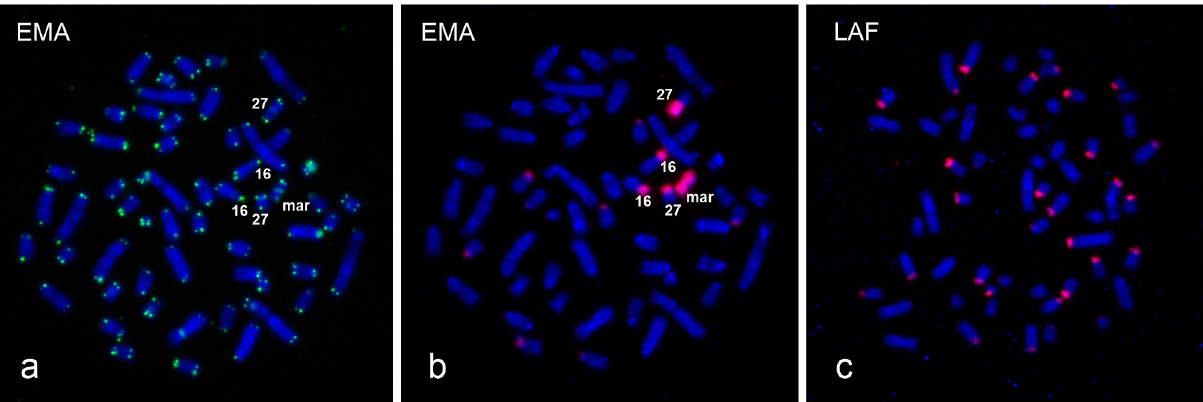
Figure 4. NOR positions in ( a ) E. maximus (2n = 57,XY,+mar) and ( b ) L. africana (2n = 56,XX).